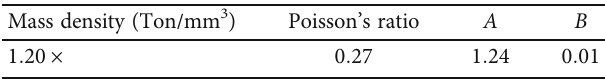
Figure 3: Passive security system fi xed to the bicycle. Table 5: Mechanical properties of polyurethane rubber with Mooney-Rivlin